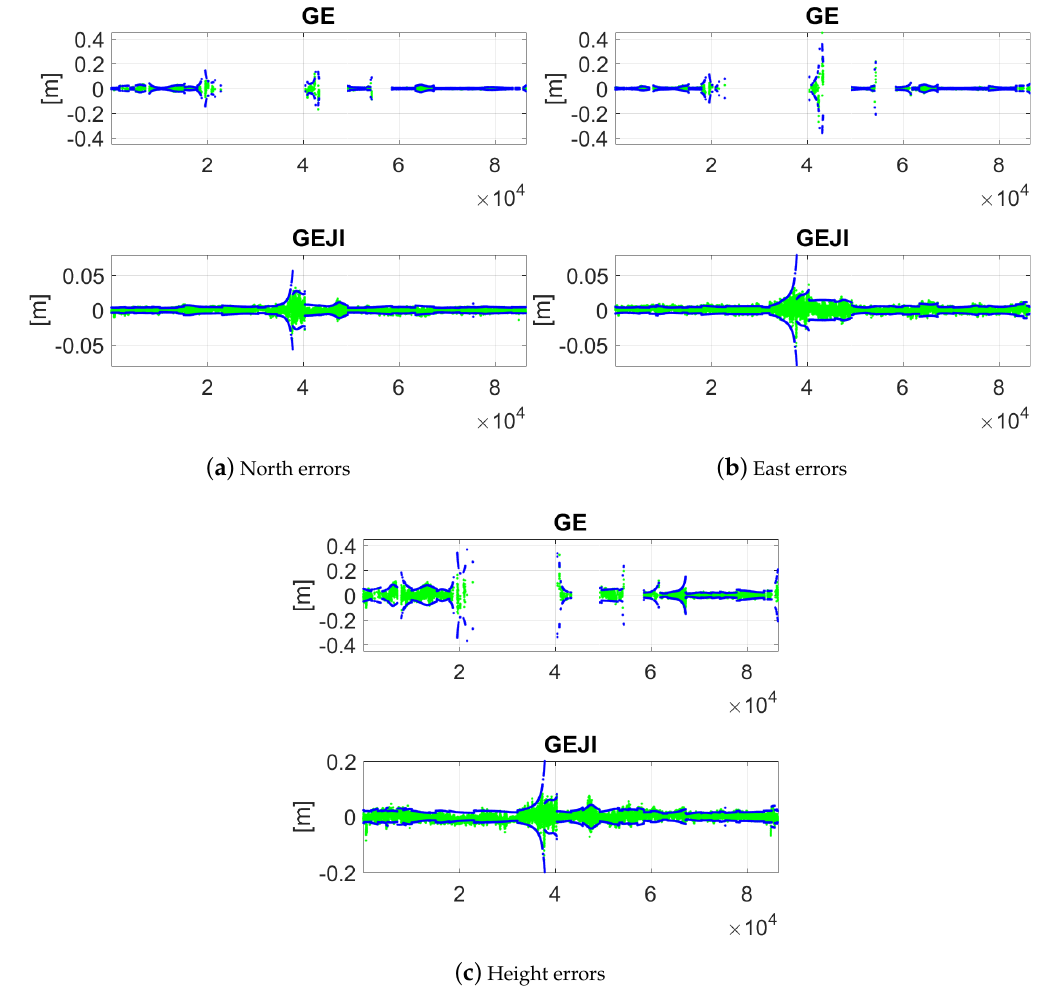
Figure 14. Ambiguity-fixed baseline errors in the north ( a ); east ( b ); and height ( c ) directions with the elevation mask of 40 degrees. Data for baseline CUAA-CUCC on DOY 224, 2018 was used. The green and blue dots are the ambiguity-correctly-fixed solutions and their 95% formal confidence intervals, respectively. Note that the scales of the sub-figures are